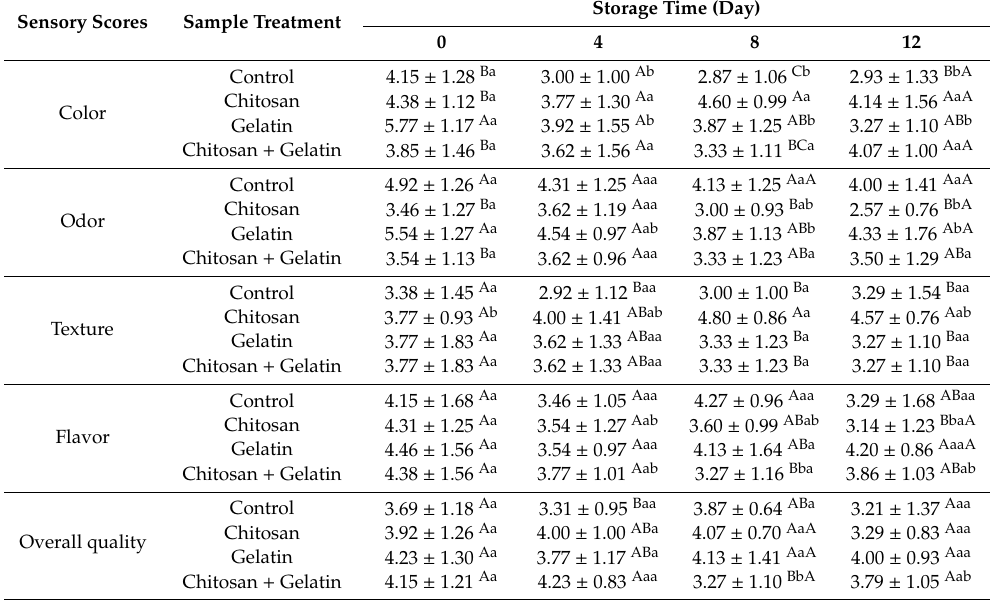
Table 6. E ff ect of the di ff erent coatings on the sensory scores of fresh-cut apple, during 12 days of storage at 5 ◦